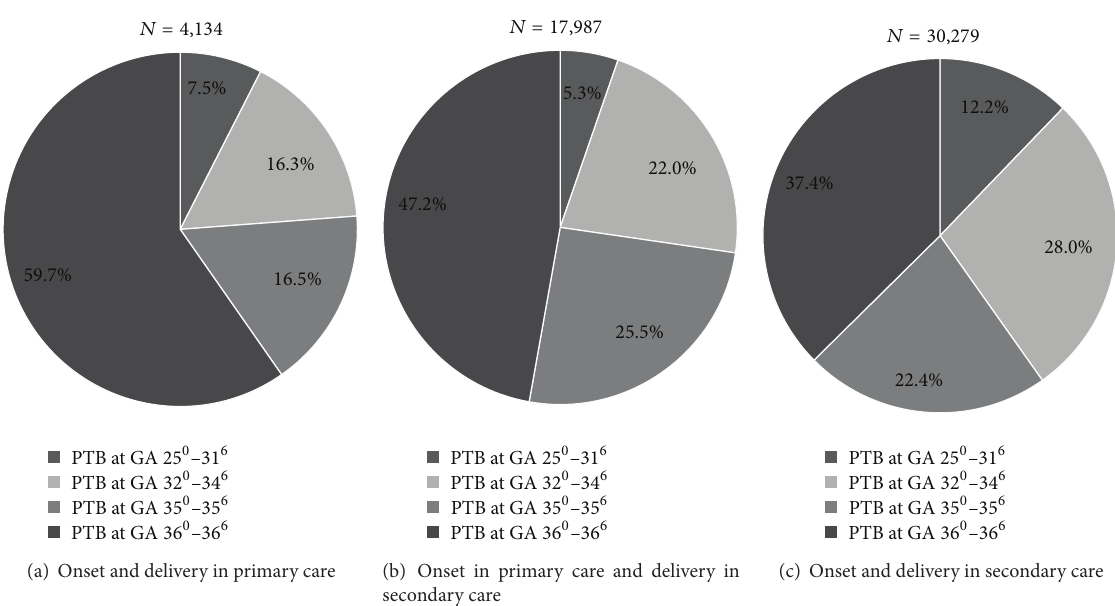
Figure 2: All preterm births ( 𝑁 = 52,397 ) per level of care divided by gestational age